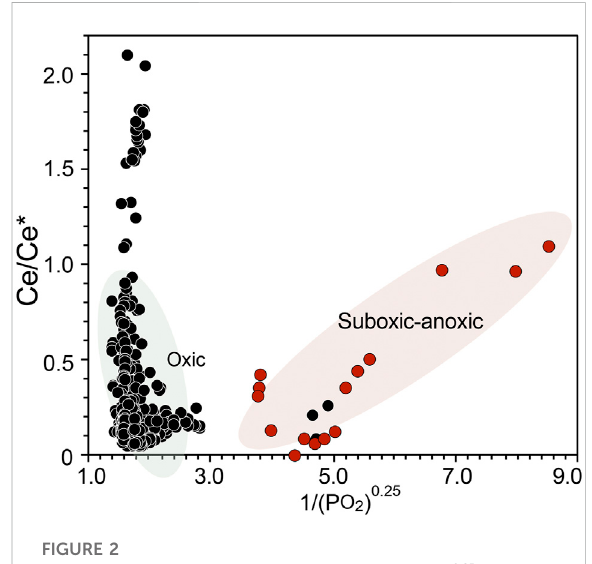
FIGURE 2 A cross-plot of compiled Ce anomalies and 1/( pO 2 ) 0.25 . Dissolved oxygen concentrations are compiled from references listedin fi gurecaptionofFigure1aswellasestimatedbyextracting annual average dissolved oxygen contents at each station utilizing WOA 13. Black circles indicate samples in oxic environments while red circles represent samples under suboxic- anoxic environments.